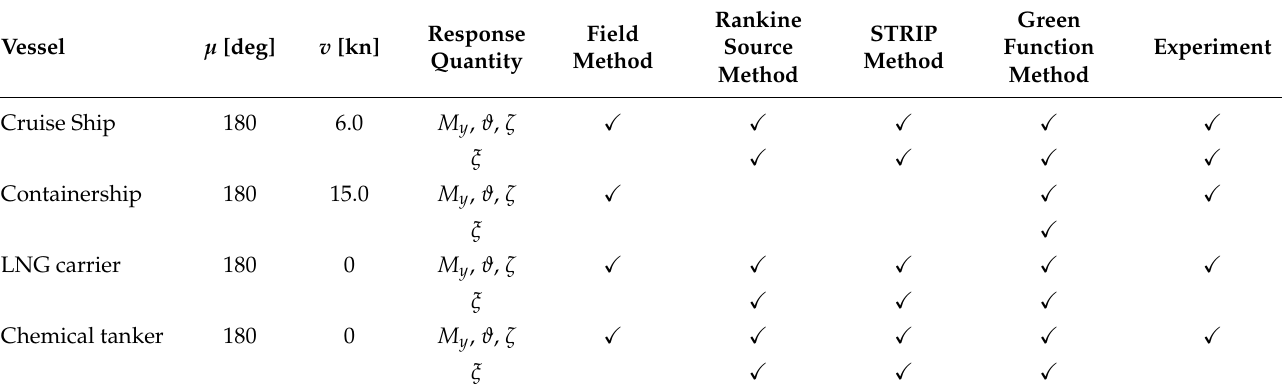
Table 3. Parameters for the determination of response amplitude operators (RAOs) and applied methods.